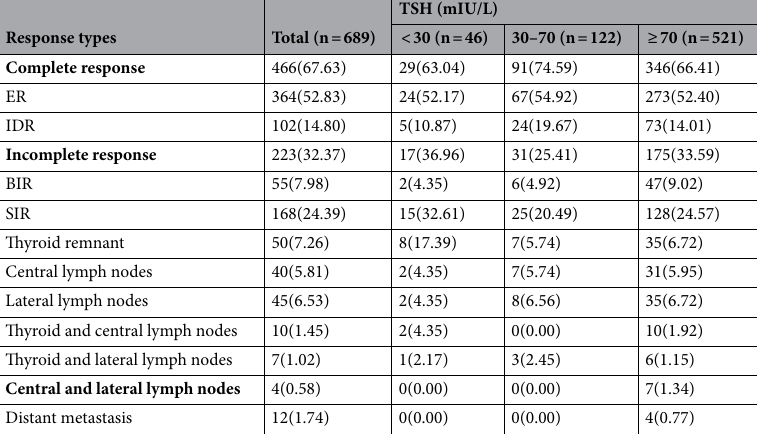
Table 3. Patients’ response types to RRA stratified by pre-ablative TSH levels. ER excellent response; IDR indeterminate response; BIR biochemical incomplete response; SIR structural incomplete response.